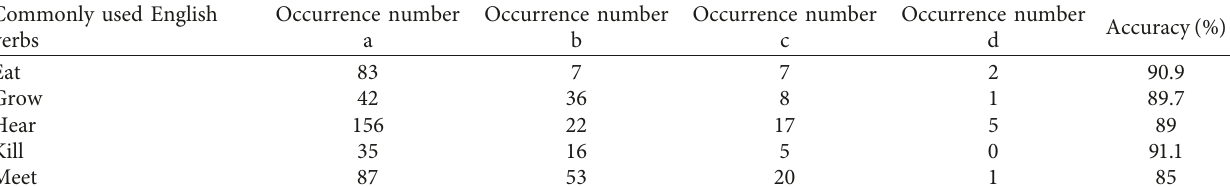
Table 6: The results of open